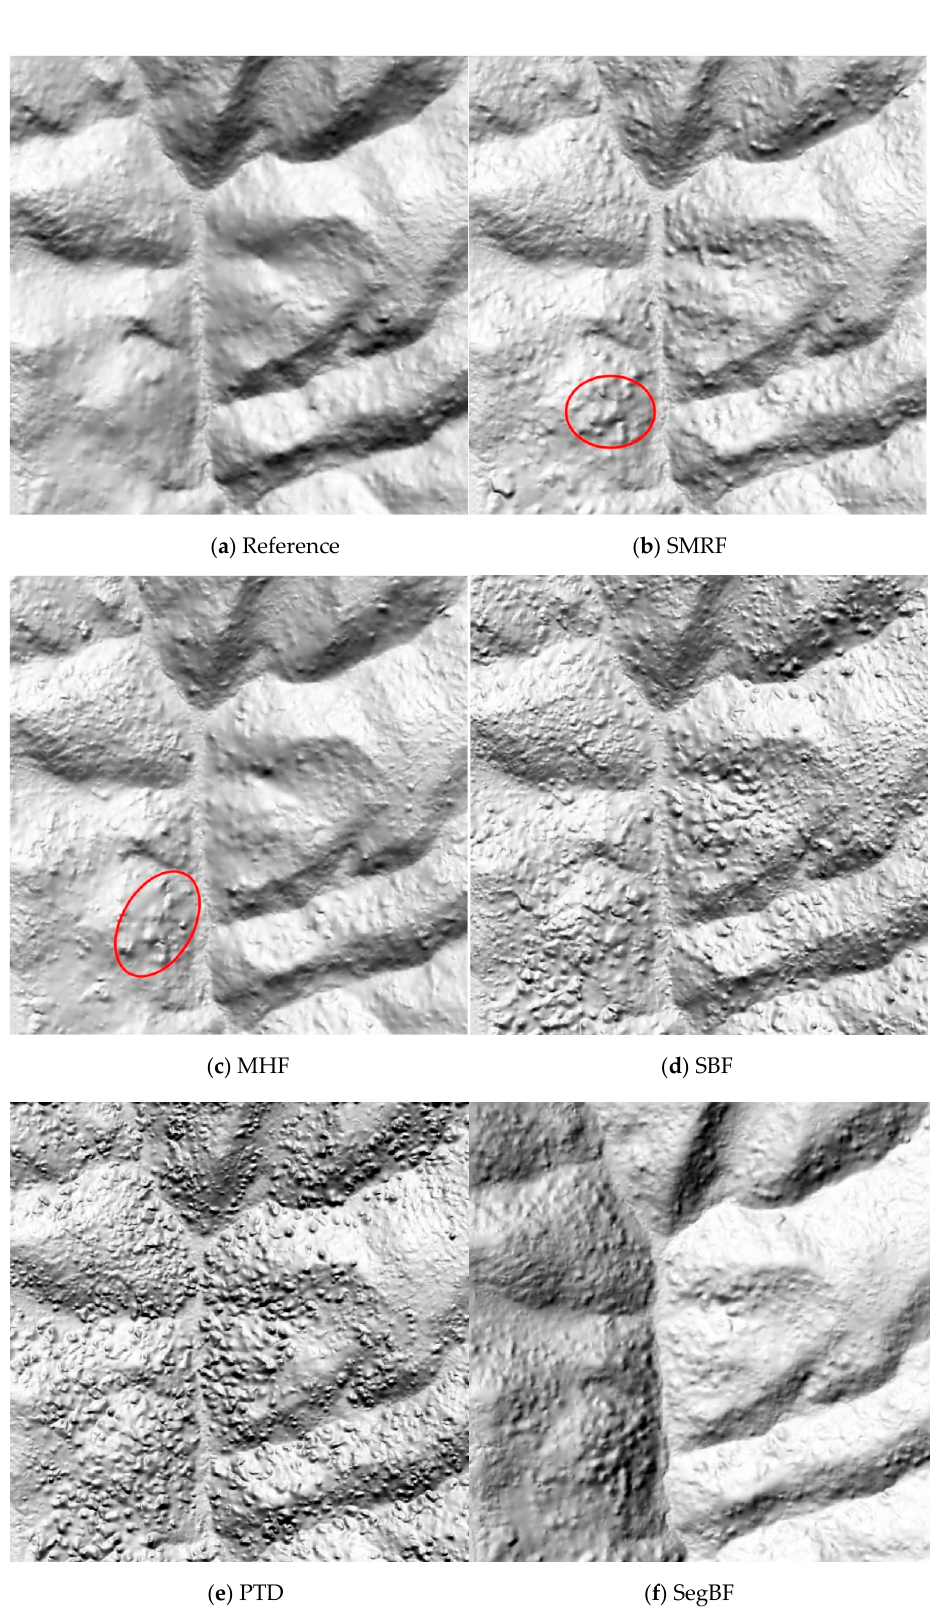
Figure 12. Reference DEM and the DEMs of all the filtering algorithms on plot 4: ( a ) Reference DEM, ( b ) SMRF, ( c ) MHF, ( d ) SBF, ( e ) PTD and ( f ) SegBF.